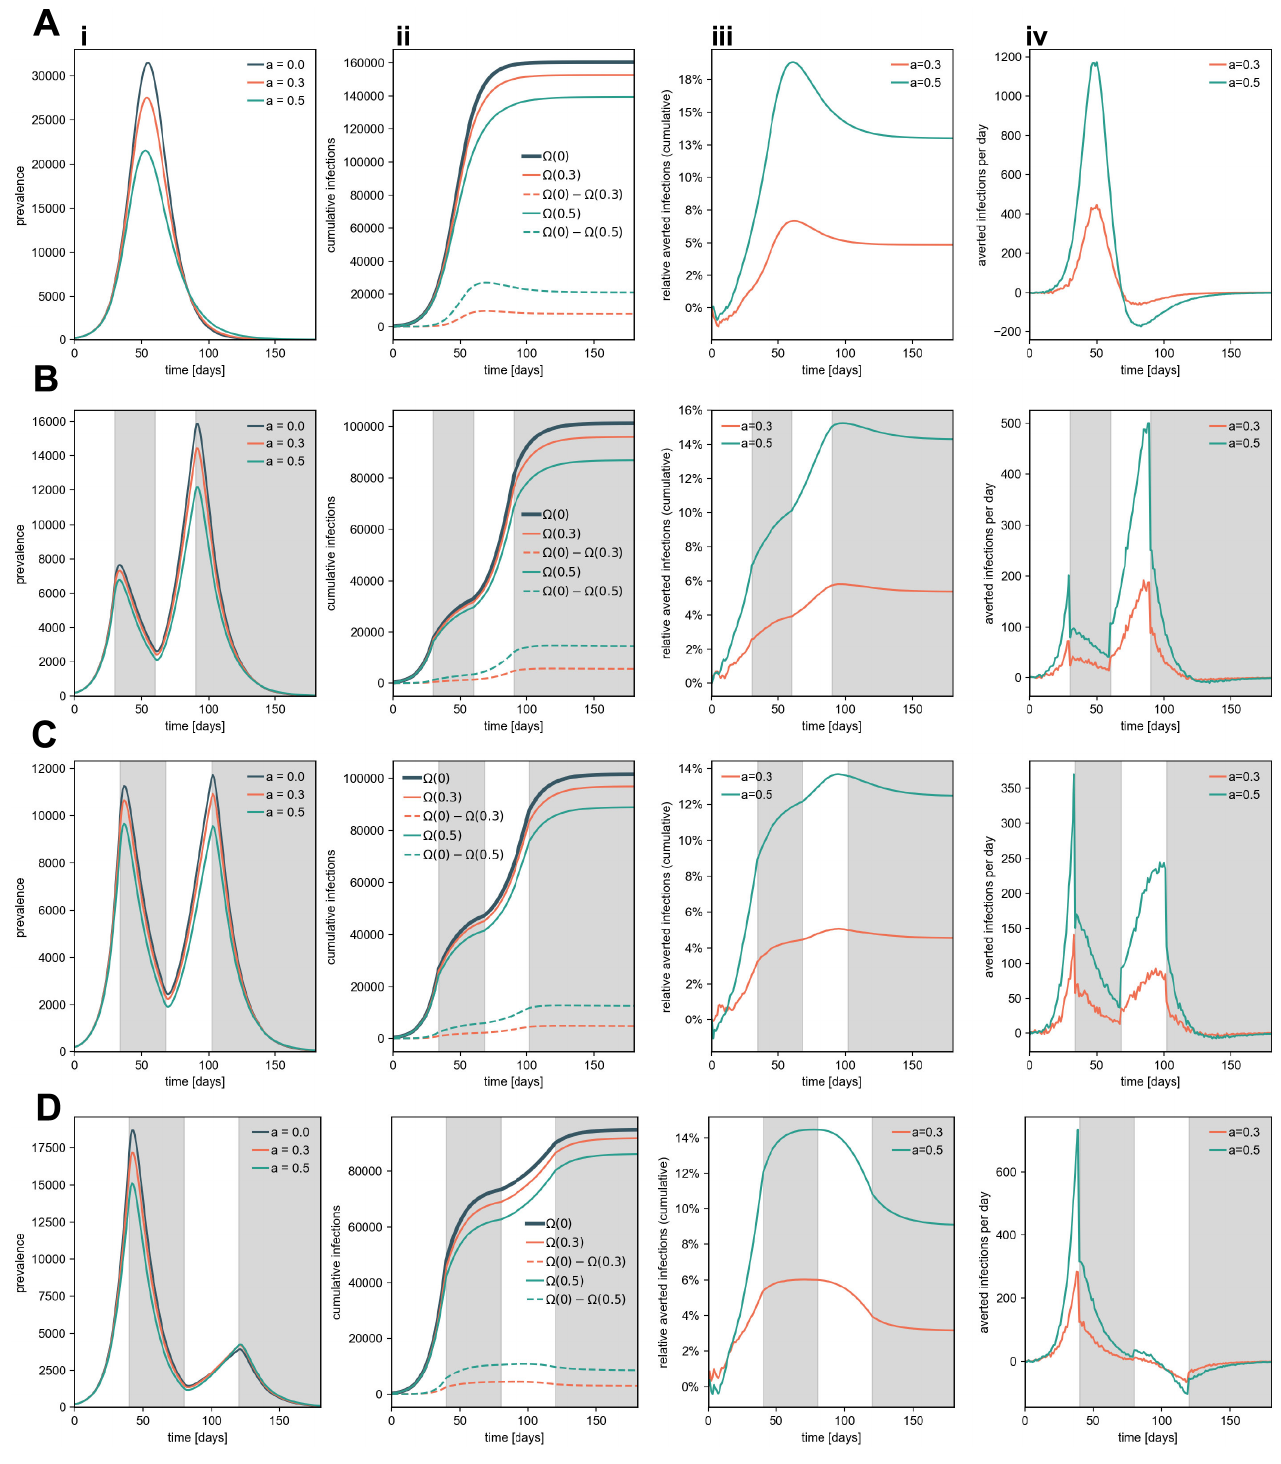
Fig 6. Comparison of (i) the prevalence, (ii) the cumulative infections O t ( a ) (and the difference between cumulative infections of “no DCT” and DCT- mitigated systems), (iii) the relative cumulative averted infections, and (iv) the prevented infections per day with a 2 {0%, 30%, 50%} app participation and detection probability q = 0.3 (A) for spread without lockdowns and (B-D) for periodically introduced lockdowns where (B) t 1 = 30d, (C) t 1 = 34d, (D) t 1 =